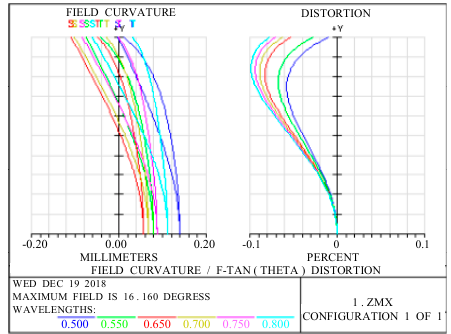
Figure 5. Field curve and distortion of the optical system.